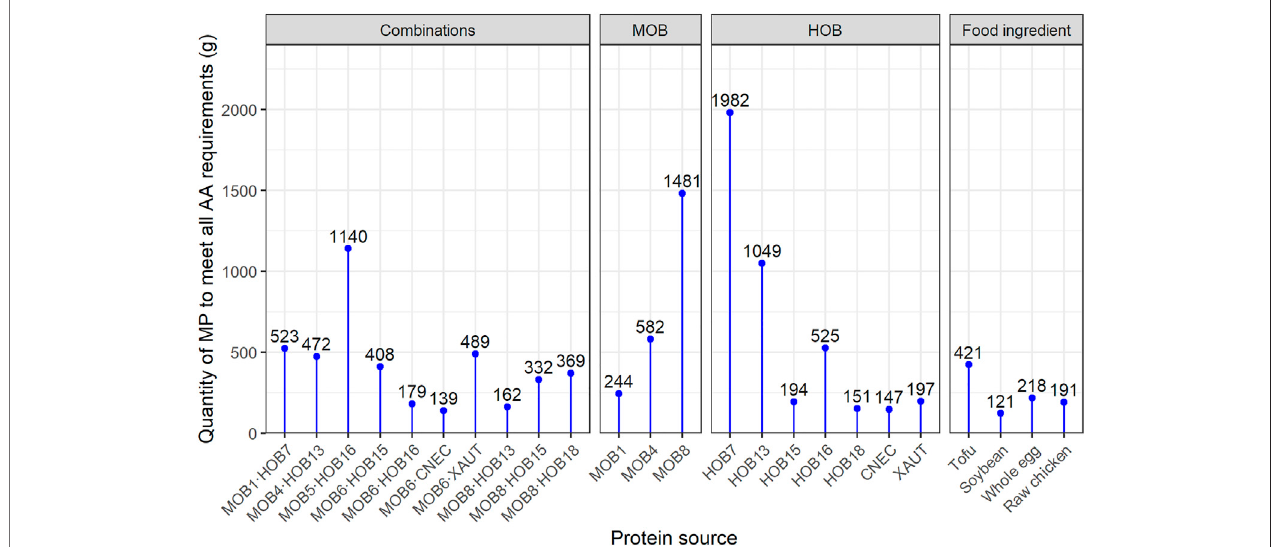
FIGURE 6 | Amount of microbial biomass and various food ingredients needed to cover the daily essential amino acid (EAA) requirements of a 62 kg person (Walpoleetal.,2012),asestablishedbyWHO/FAO/UNU(2007).TheEAAcontentofmicrobialproteiniscalculatedtakingintoaccount5%ofmoistureinthe fi nalproduct (Chemical Composition 1-Unibio, 2021). MOB 5 and MOB 6 were not included due to poor data quality. More information can be found in the Supplementary Tables S9, S10 .